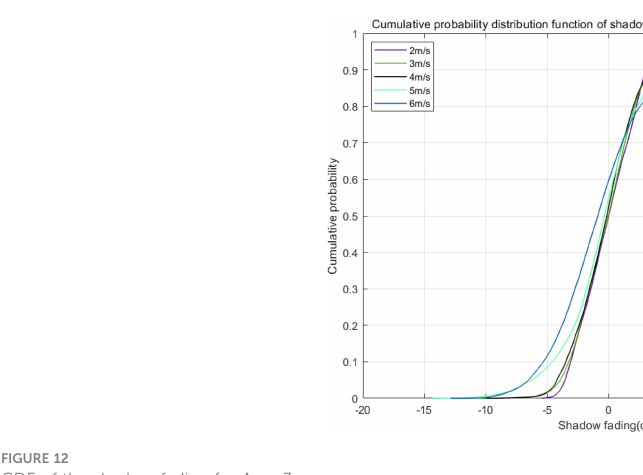
FIGURE 12 CDF of the shadow fading for Area